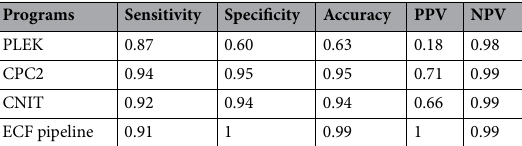
Table 2. Performance of lncRNA identification tools and ECF pipeline on Drosophila melanogaster dataset.